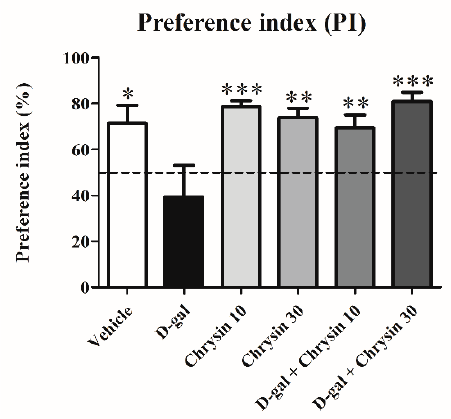
Figure 4. The PIs (mean ± SEM) of the NOR test after treatment. The PIs of the vehicle, chrysin 10, chrysin 30, and D-gal + chrysin groups differed significantly from 50% chance (* p < 0.05, ** p < 0.01, *** p < 0.001), but that of the D-gal group did not ( p > 0.05).